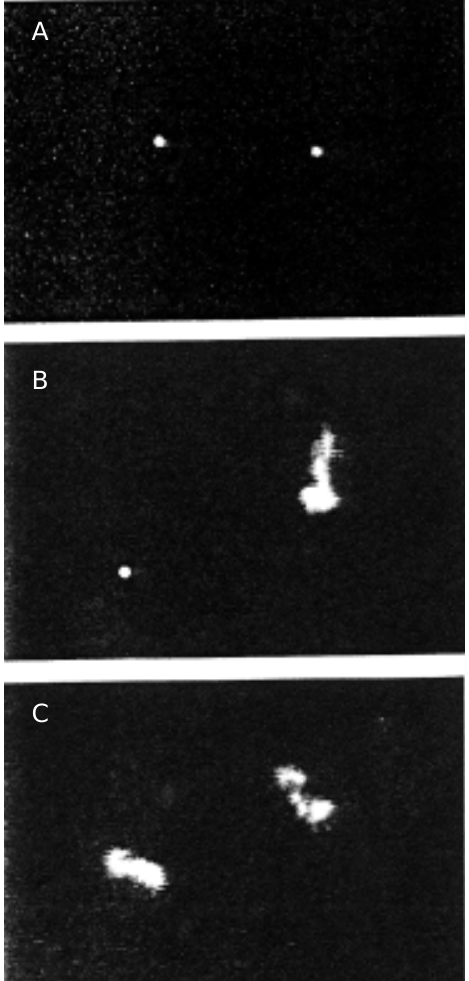
Figure 12. A , T4 DNA molecules in the compacted conformation due to the presence of the cat- ionic surfactant cetyltrimethyl- ammonium bromide (CTAB), in solution. B , For intermediate amounts of the anionic surfac- tant sodium octylsulfate (SOS), we can see a coexistence be- tween the two DNA conforma- tions, i.e., coils and globules. C , With further addition of SOS all molecules undergo decompac- tion. T = 25 (cid:1)